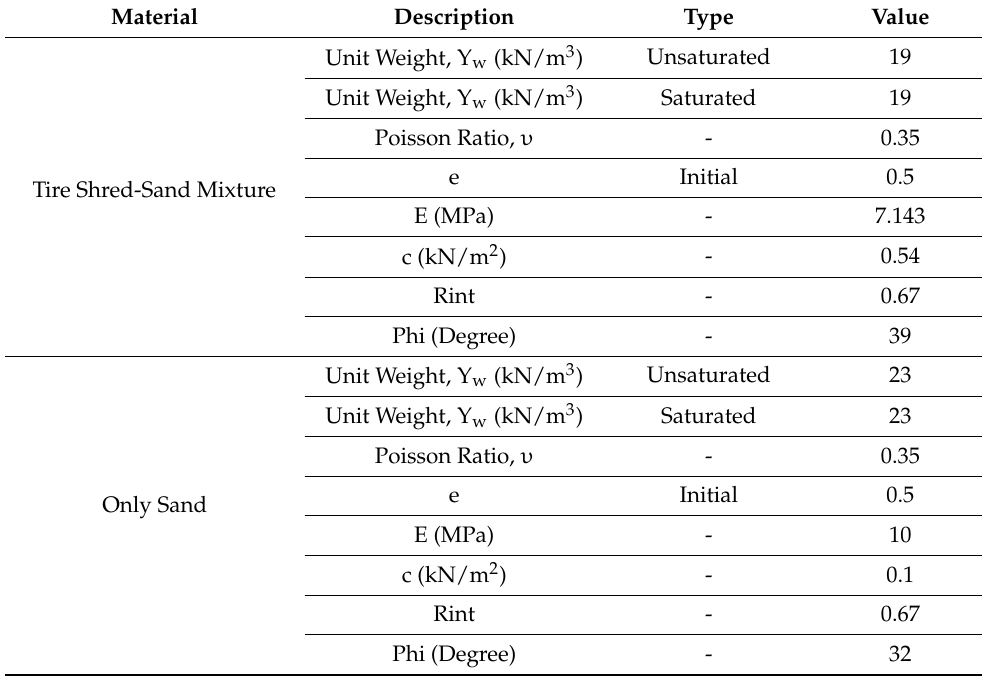
Figure 7. Different stages of the model construction phase in Plaxis 3D: ( a ) Soil phase; ( b ) Structure phase (model with box and deformed bars); ( c ) Illustration of the top plate with load application; ( d ) Meshed model of Plaxis 3D. Table 1. Properties of material and